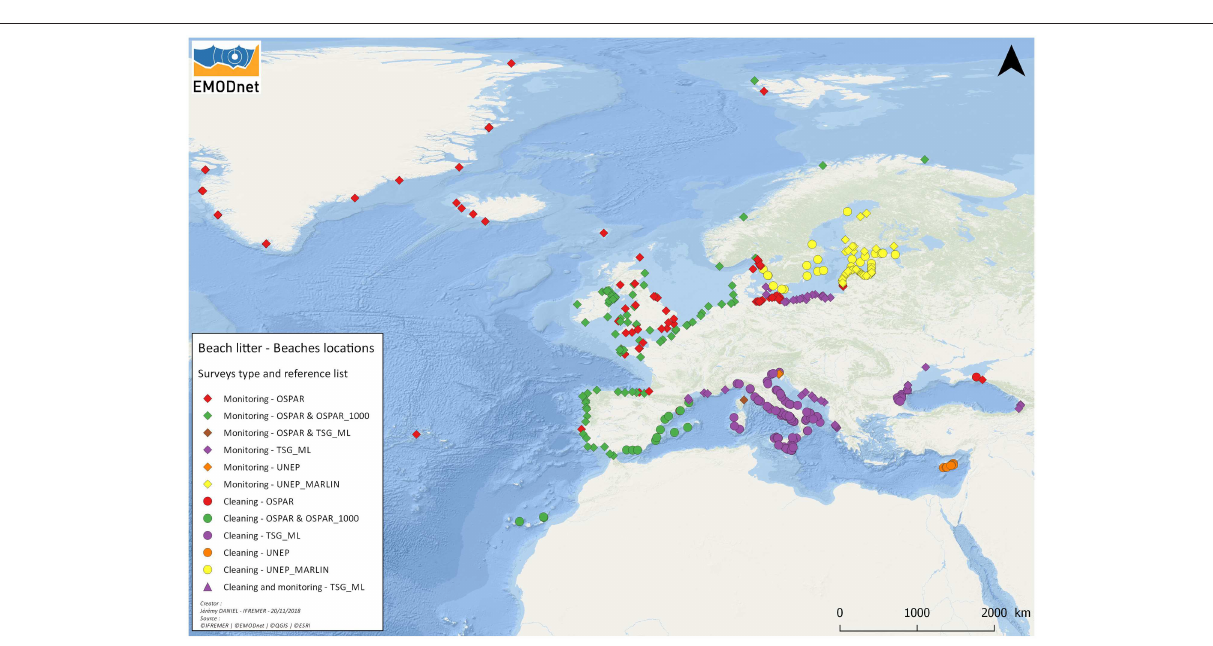
Table 2 . To identify characteristics (spectral bands,